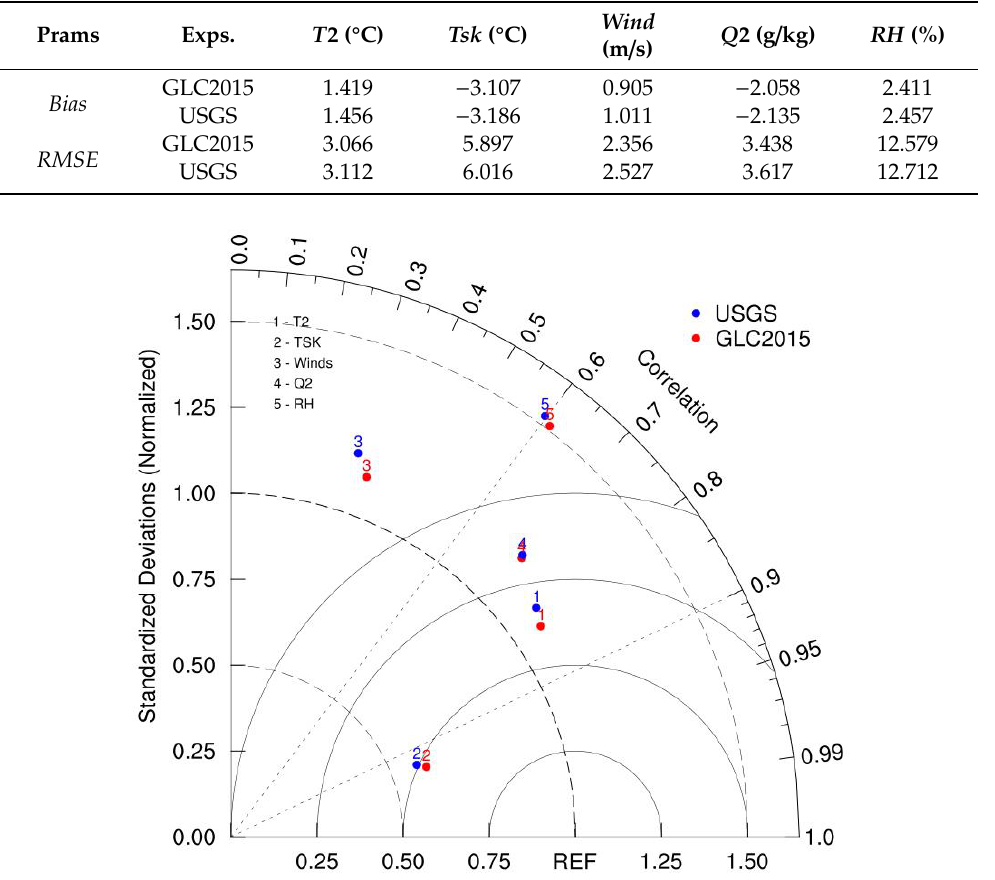
Figure 11. Taylor diagram of the performance of T 2, T sk , Winds , Q 2 and RH simulated using the GLC2015 and USGS data for whole D02 domain (red points indicate GLC2015 values, and blue are USGS values).